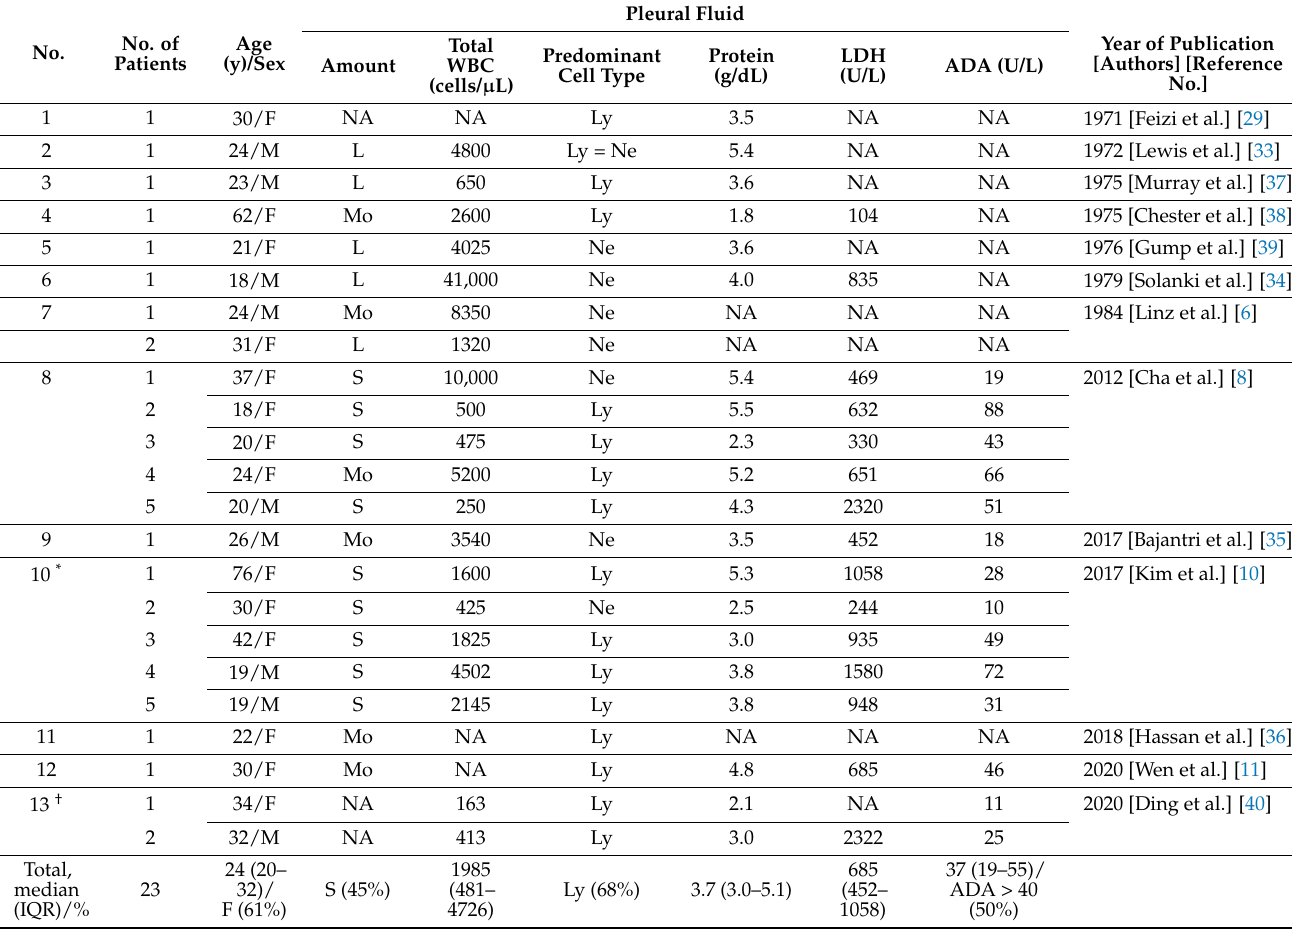
Table 1. Literature review of pleural fluid analysis providing differential leukocyte counts or ADA levels in adult patients with Mycoplasma pneumoniae parapneumonic